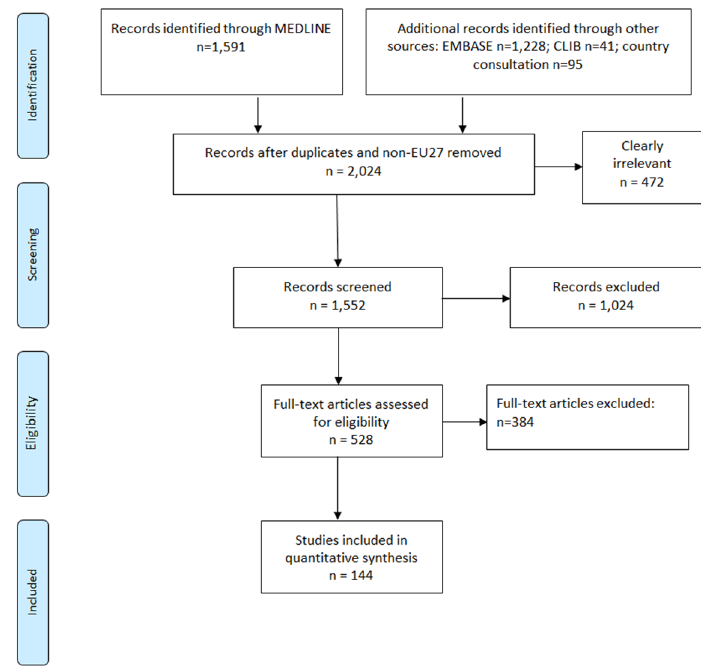
Figure 1. Flow diagram of study selection aggregated over the seven topic areas reviewed. doi:10.1371/journal.pone.0103345.g001 PLOS ONE |